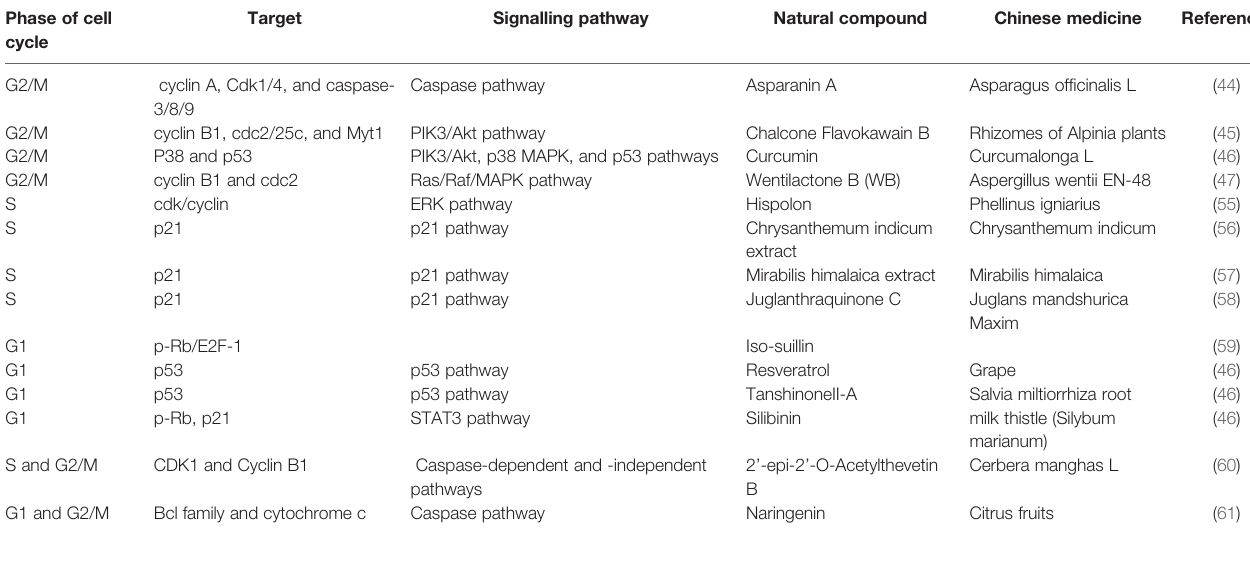
TABLE 1 | The targets and pathways of natural compounds in the process of arresting cell cycle progression in HCC. Phase of cell